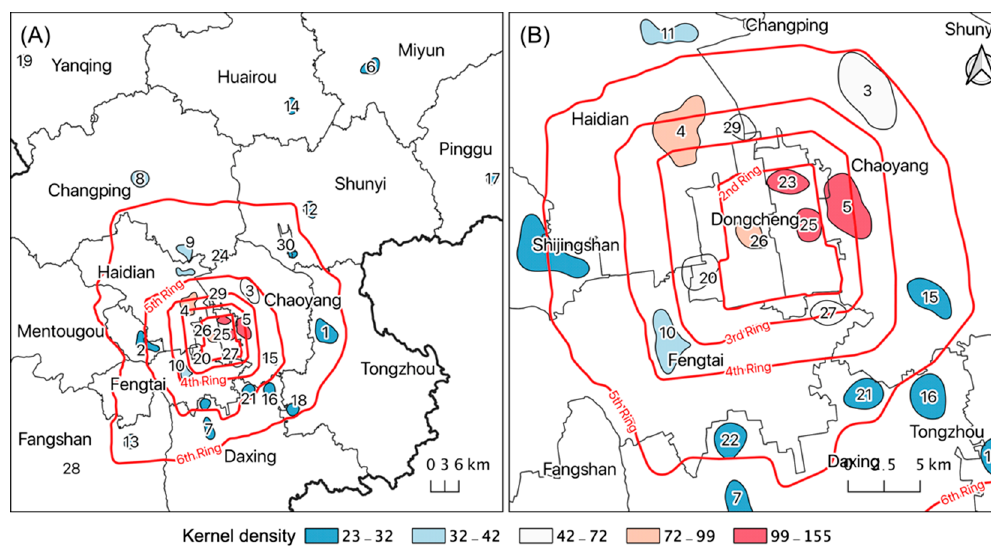
Figure 10. Spatial distribution of accommodation and catering centers in Beijing ( A ) and the Fifth Ring Road ( B ).